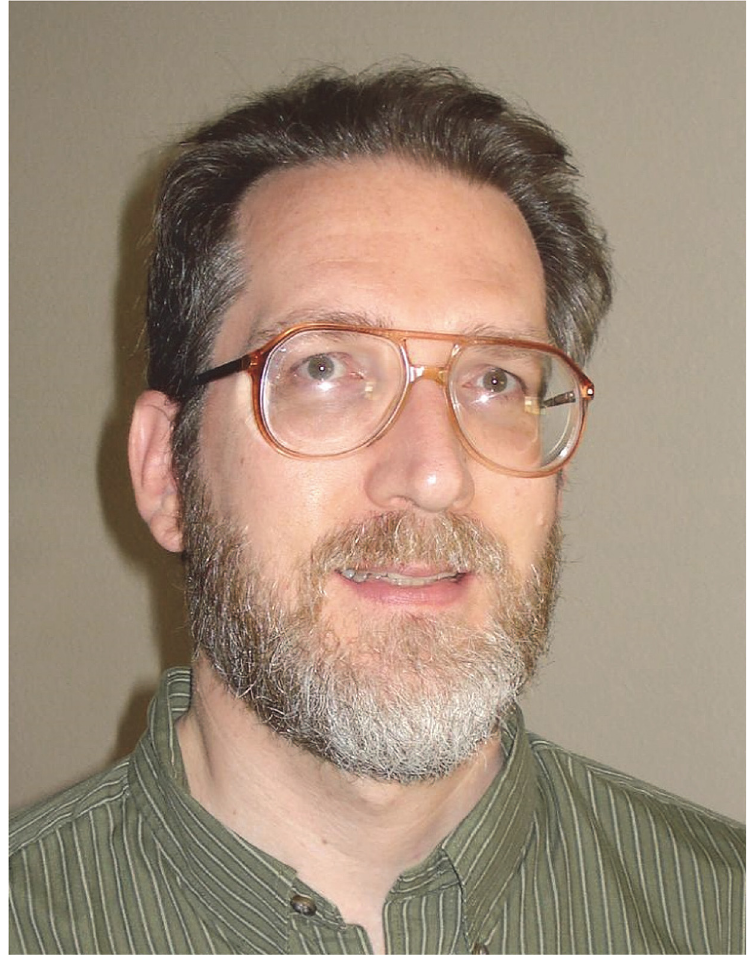
Fig 4. Scott Markel. Secretary, ISCB. BIOVIA principal bioinformatics architect at Dassault Syst è